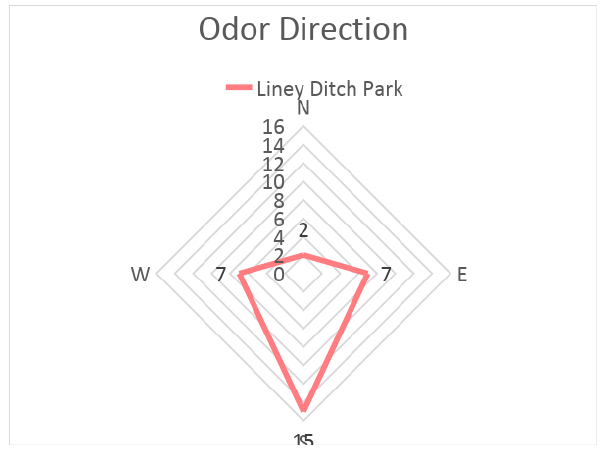
Figure 2. Sample of nasal ranger readings at Liney Ditch